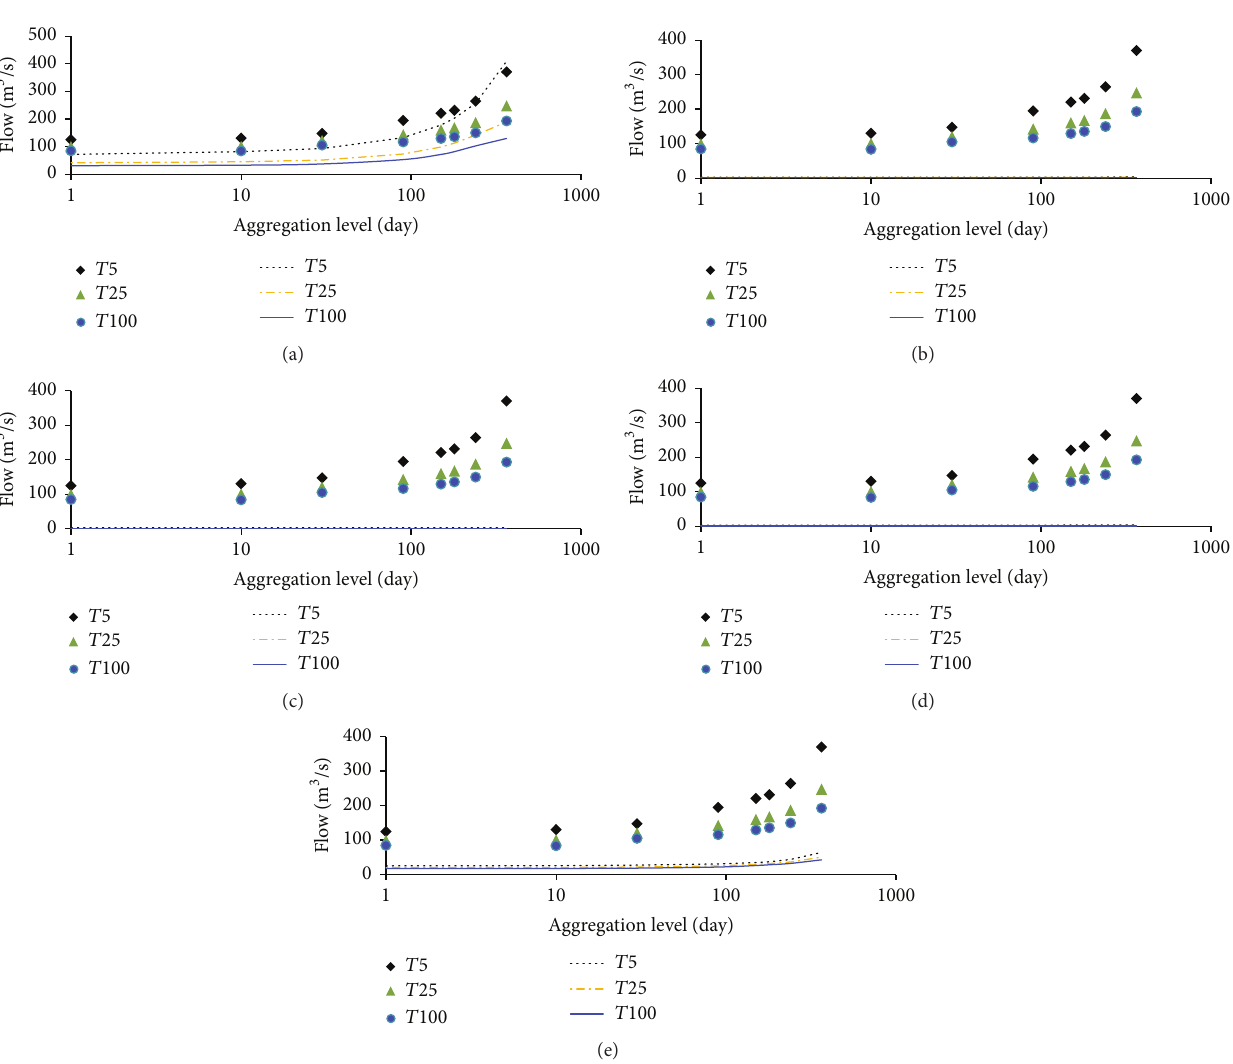
40 years were − 0.55% (AWBM), 5.30% (IHACRES), 6.35% (SAC), 79.56% (SIMHYD), and − 6.28% (TANK). For low flows, the corresponding biases of − 53.51% (AWBM), − 99.98% (IHACRES), − 100% (SAC), − 99.99%